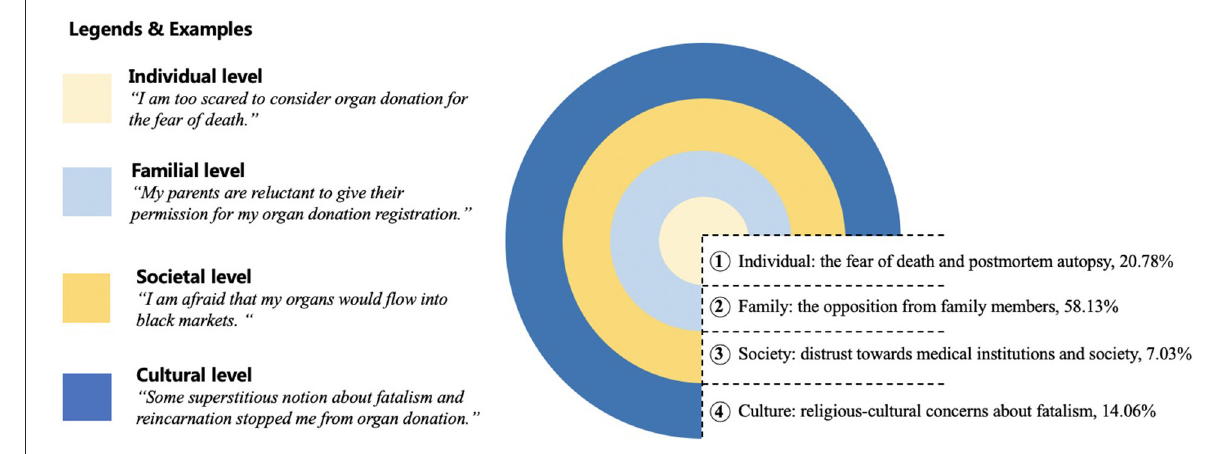
FIGURE3 Hindrances to organ donation derived from the conventional content